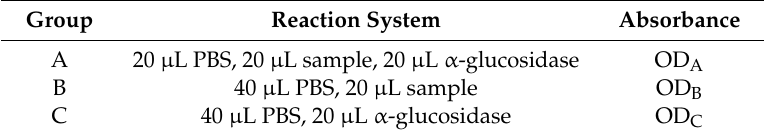
Table 1. Specific grouping and reaction system for α -glucosidase inhibitory activity.